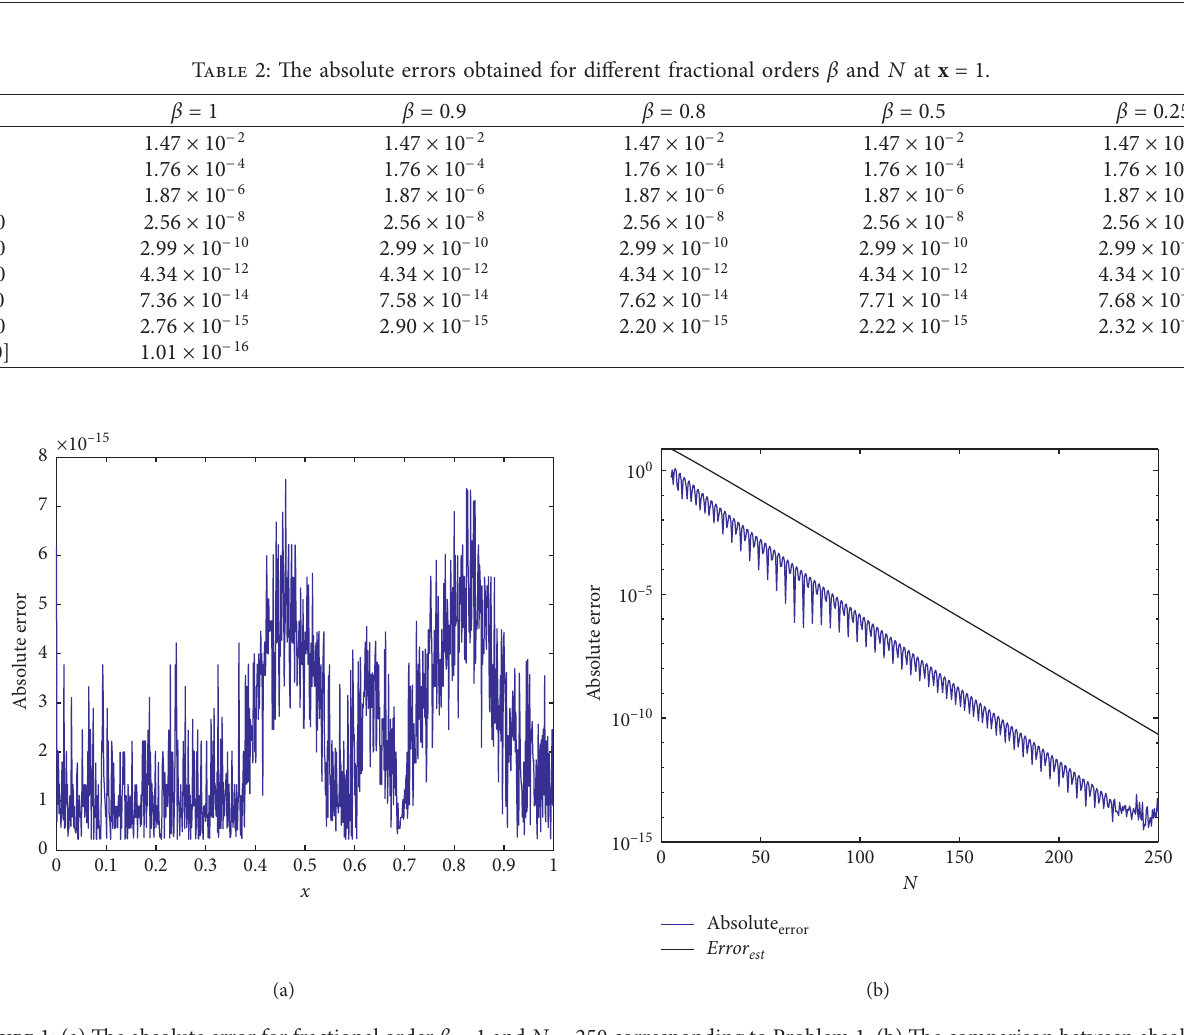
Figure 1: (a) The absolute error for fractional order β � 1 and N � 250 corresponding to Problem 1. (b) The comparison between absolute error and error at x � 1, N � 250, θ � 0 . 10 , η � 0 . 1541 , r � 0 . 1387 , r � 2 π r, ϑ � 2 . 0, and β � 1 for Problem 1. A good agreement between est them is